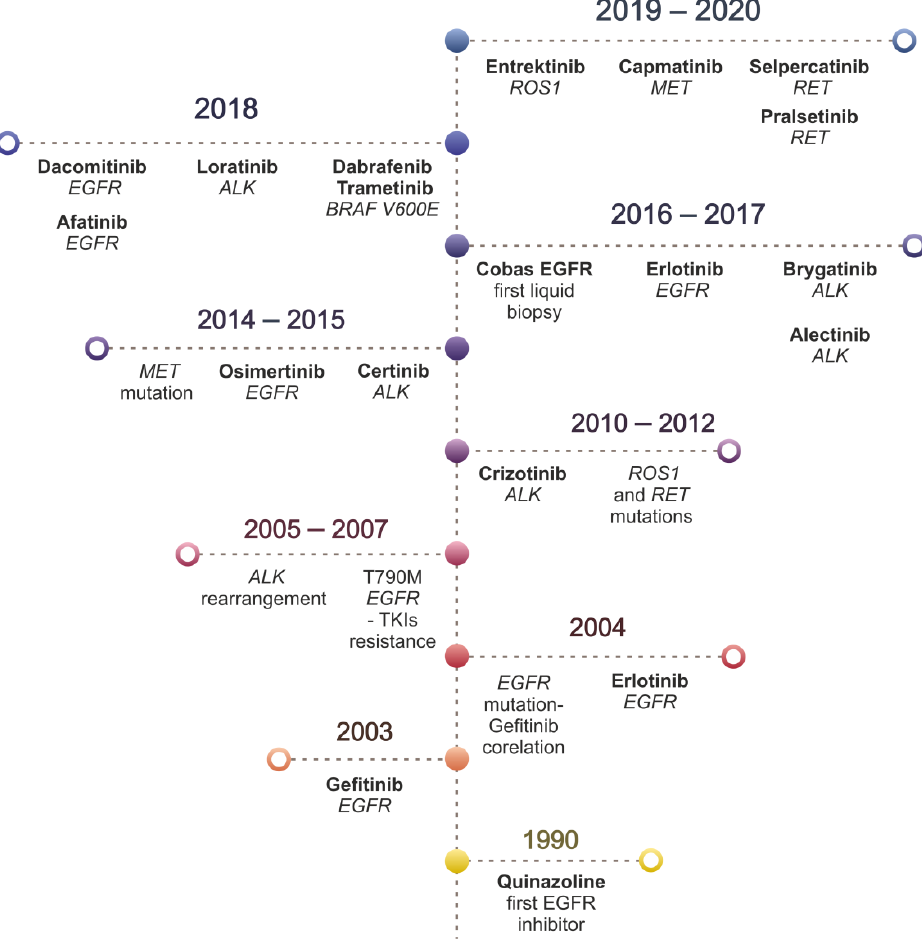
Figure 1. Development of targeted therapy in NSCLC. Over the last decade, there has been an acceleration in the emergence of new inhibitors approved in NSCLC targeted therapy. The approval dates of the inhibitors in the treatment of NSCLC refer to the approvals issued by the Food and Drug Administration (FDA), Silver Spring, MA, USA.